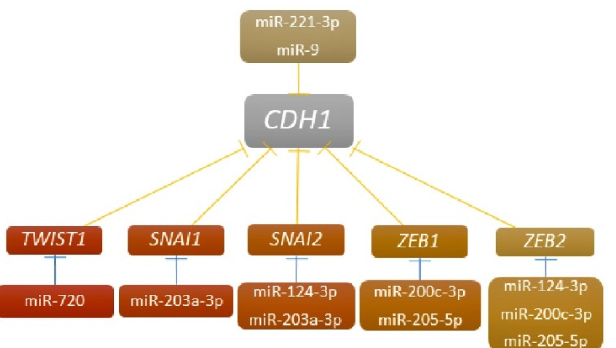
Figure 1. Diagram of associations in inhibition of CDH1 expression adapted from results of in vitro studies.